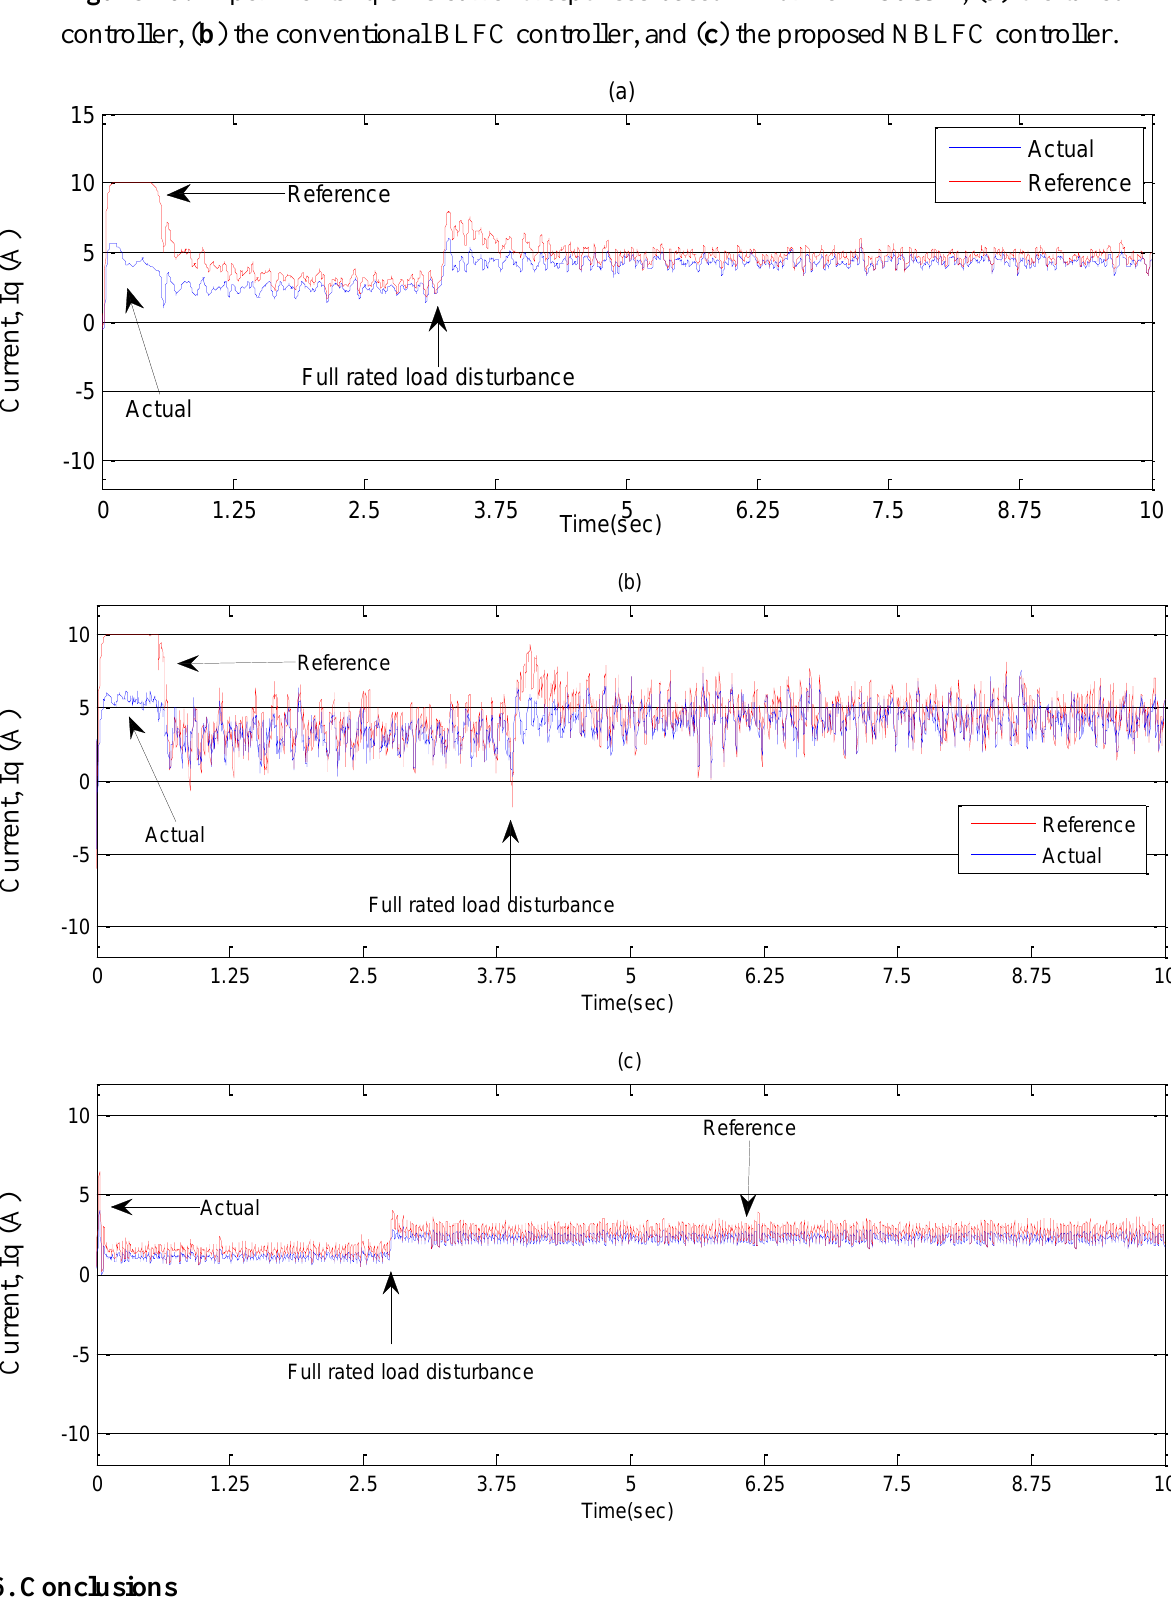
Figure 20. Experimental q-axis current responses-based IM drive in Case-2 ; ( a ) the tuned PI controller, ( b ) the conventional BLFC controller, and ( c ) the proposed NBLFC